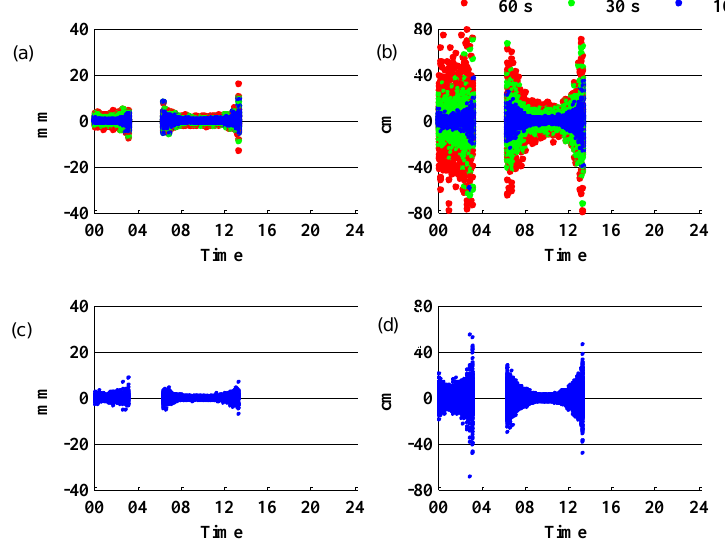
Figure 3. Observation noise on B1I for C21 at HARB for one day. Carrier-phase and pseudorange residuals calculated by the polynomial fitting of different time lengths are shown in ( a , b ). Triple- differenced carrier-phase and pseudorange measurements are shown in ( c , d ).